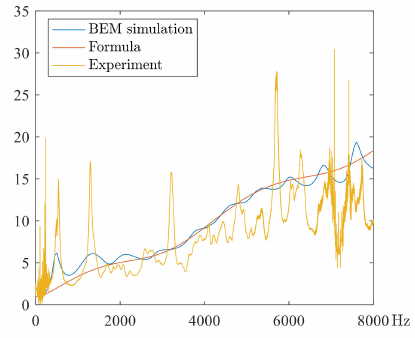
Figure 3. The results of